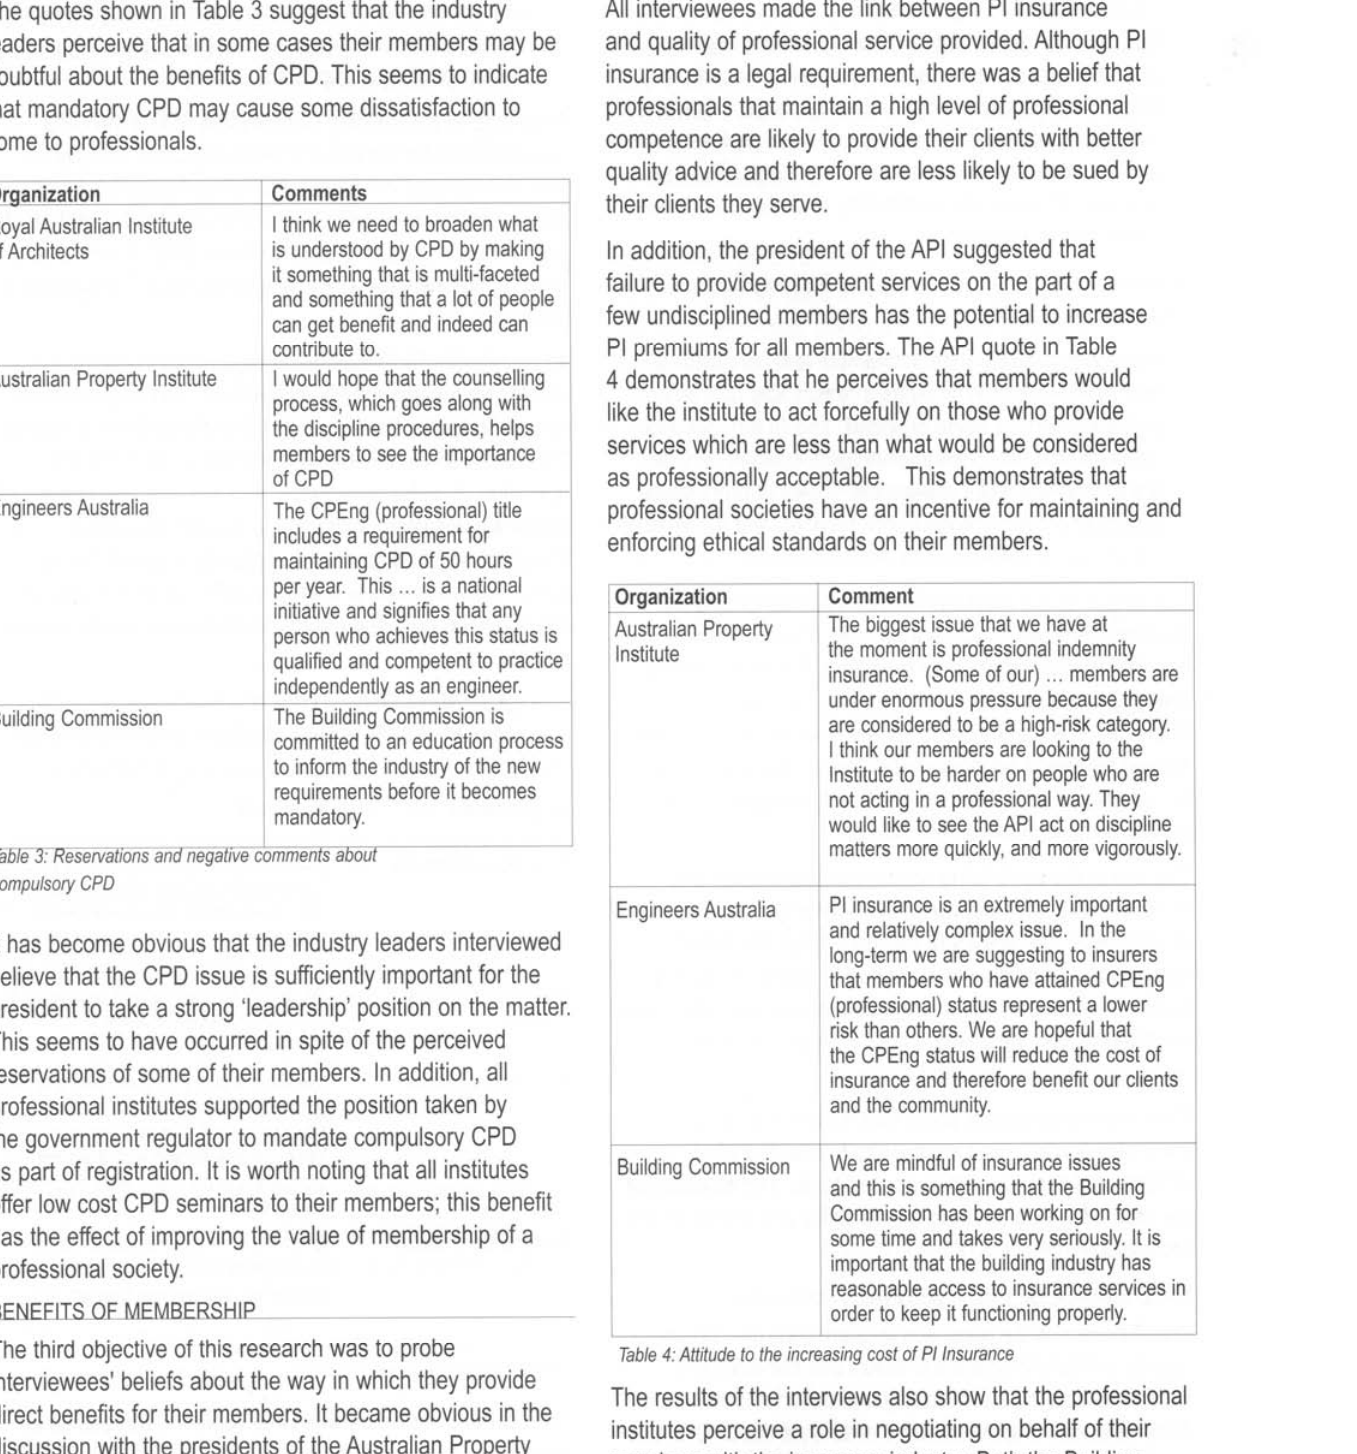
Table 4: Attitude to the increasing cost of PI